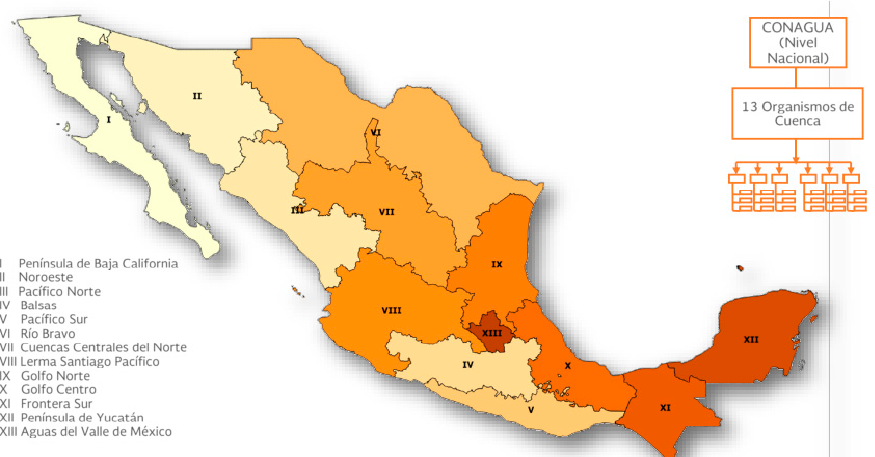
Figure 2. The geographical configuration of Mexico from the 13 RHAs for the management of water resources [62].